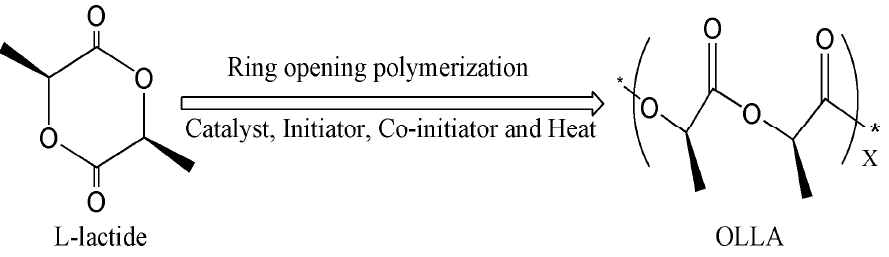
Figure 1. Synthesis of oligomer (low molecular weight PLLA).